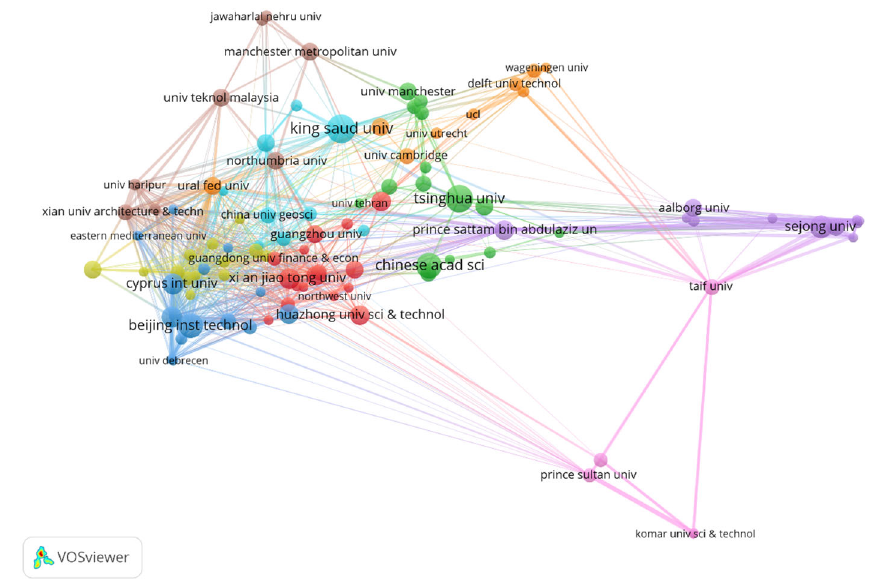
Figure 4. Bibliographic coupling of organizations.